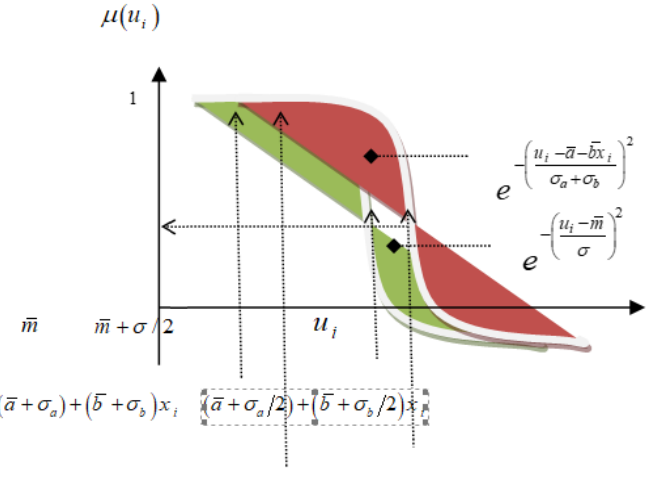
Fig. 3. R Gaussian fuzzy number with a